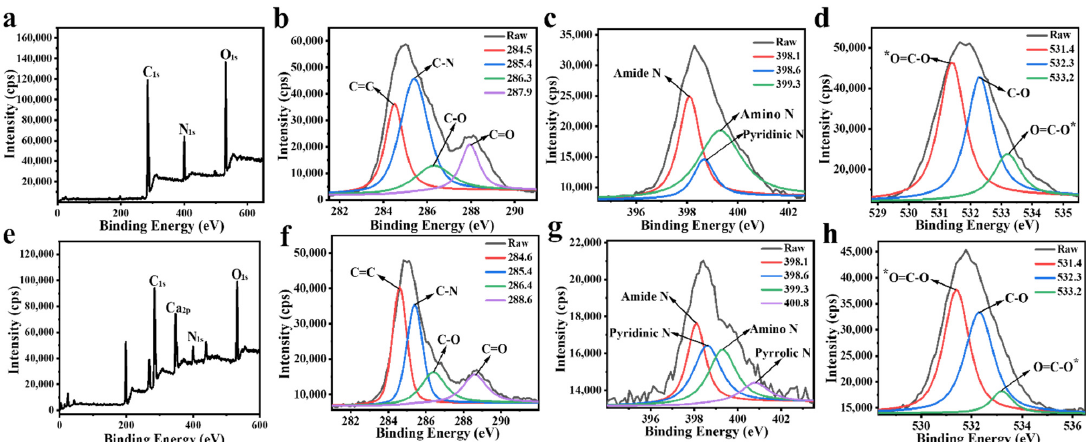
Figure 4. XPS survey of FNs ( a ) and FNs-Ca(II) ( e ). High-resolution XPS spectra of C 1s ( b ), N 1s ( c ), and O 1s ( d ) for FNs, and high-resolution XPS spectra of C 1s ( f ), N 1s ( g ), and O 1s ( h ) for FNs-Ca(II).